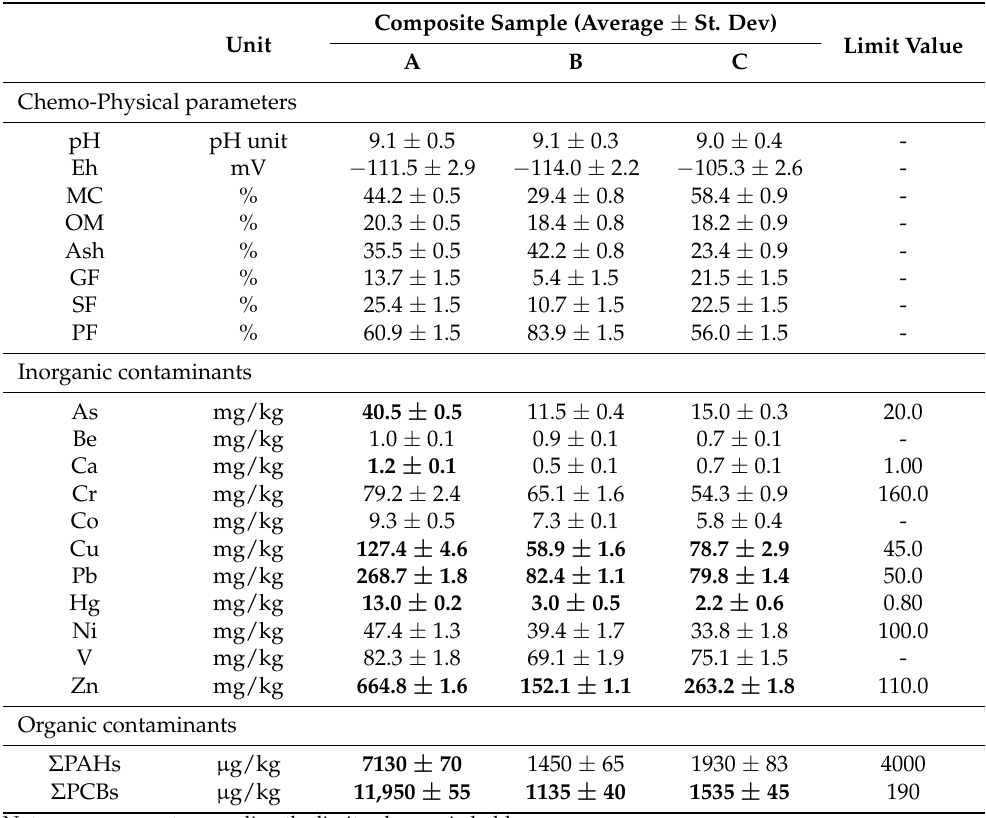
Table 3. Chemo-physical and particle-size characterizations of composite